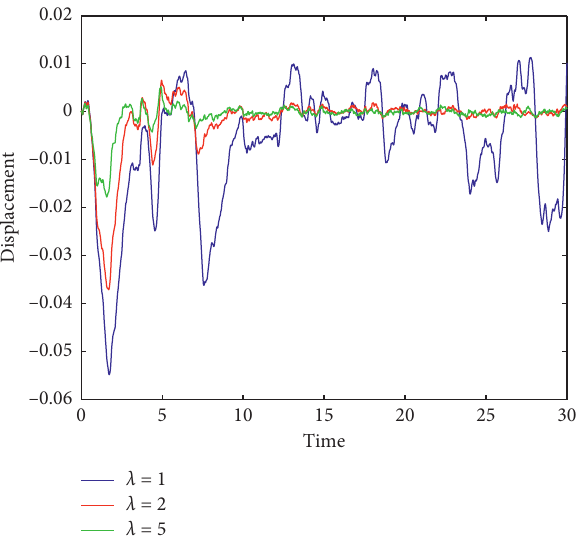
Figure 14: The horizontal displacement amplitude of the active system for different λ values and η � 1.